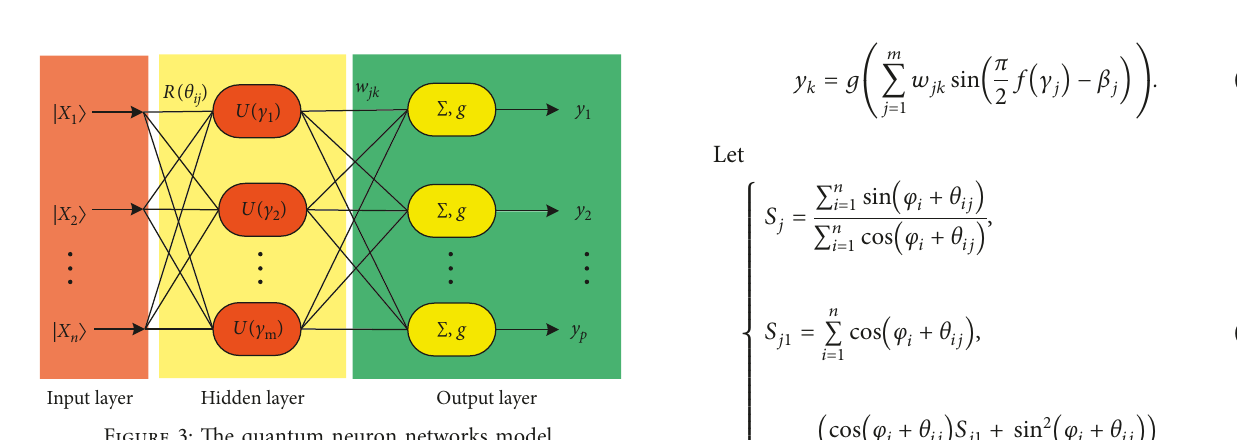
Figure 2: The quantum neuron model.